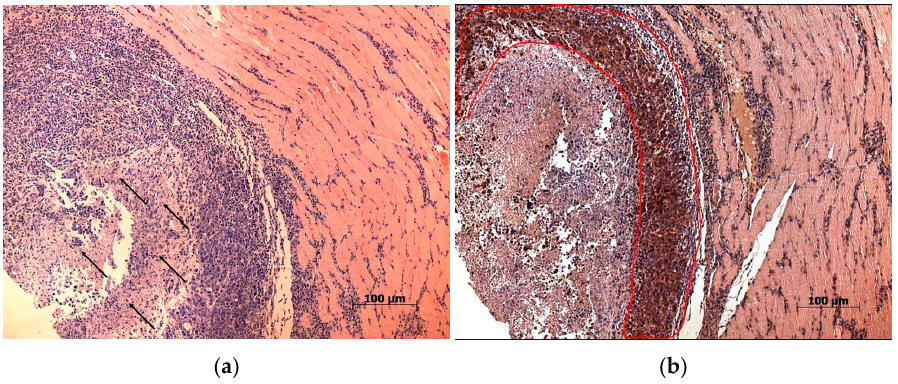
Figure 4. ( a ) Necrotic changes in a Krebs-2 solid tumor node of a mouse receiving NDV/Altai/pigeon/770/2011 injections and with a significant tumor reduction in MRI. Day 20 after virotherapy (day 28 of tumor growth), hematoxylin-eosin staining, 10 × magnification. Arrows indicate necrotic areas in the tumor node; ( b ) Krebs-2 solid tumor node, immunohistochemical evaluation of the NDV/Altai/pigeon/770/2011 strain. Day 20 after virotherapy (day 28 of tumor growth), additional staining with hematoxylin, 10 × magnification. Tumor cells showing a positive reaction with antibodies against the whole virion of NDV are encircled in